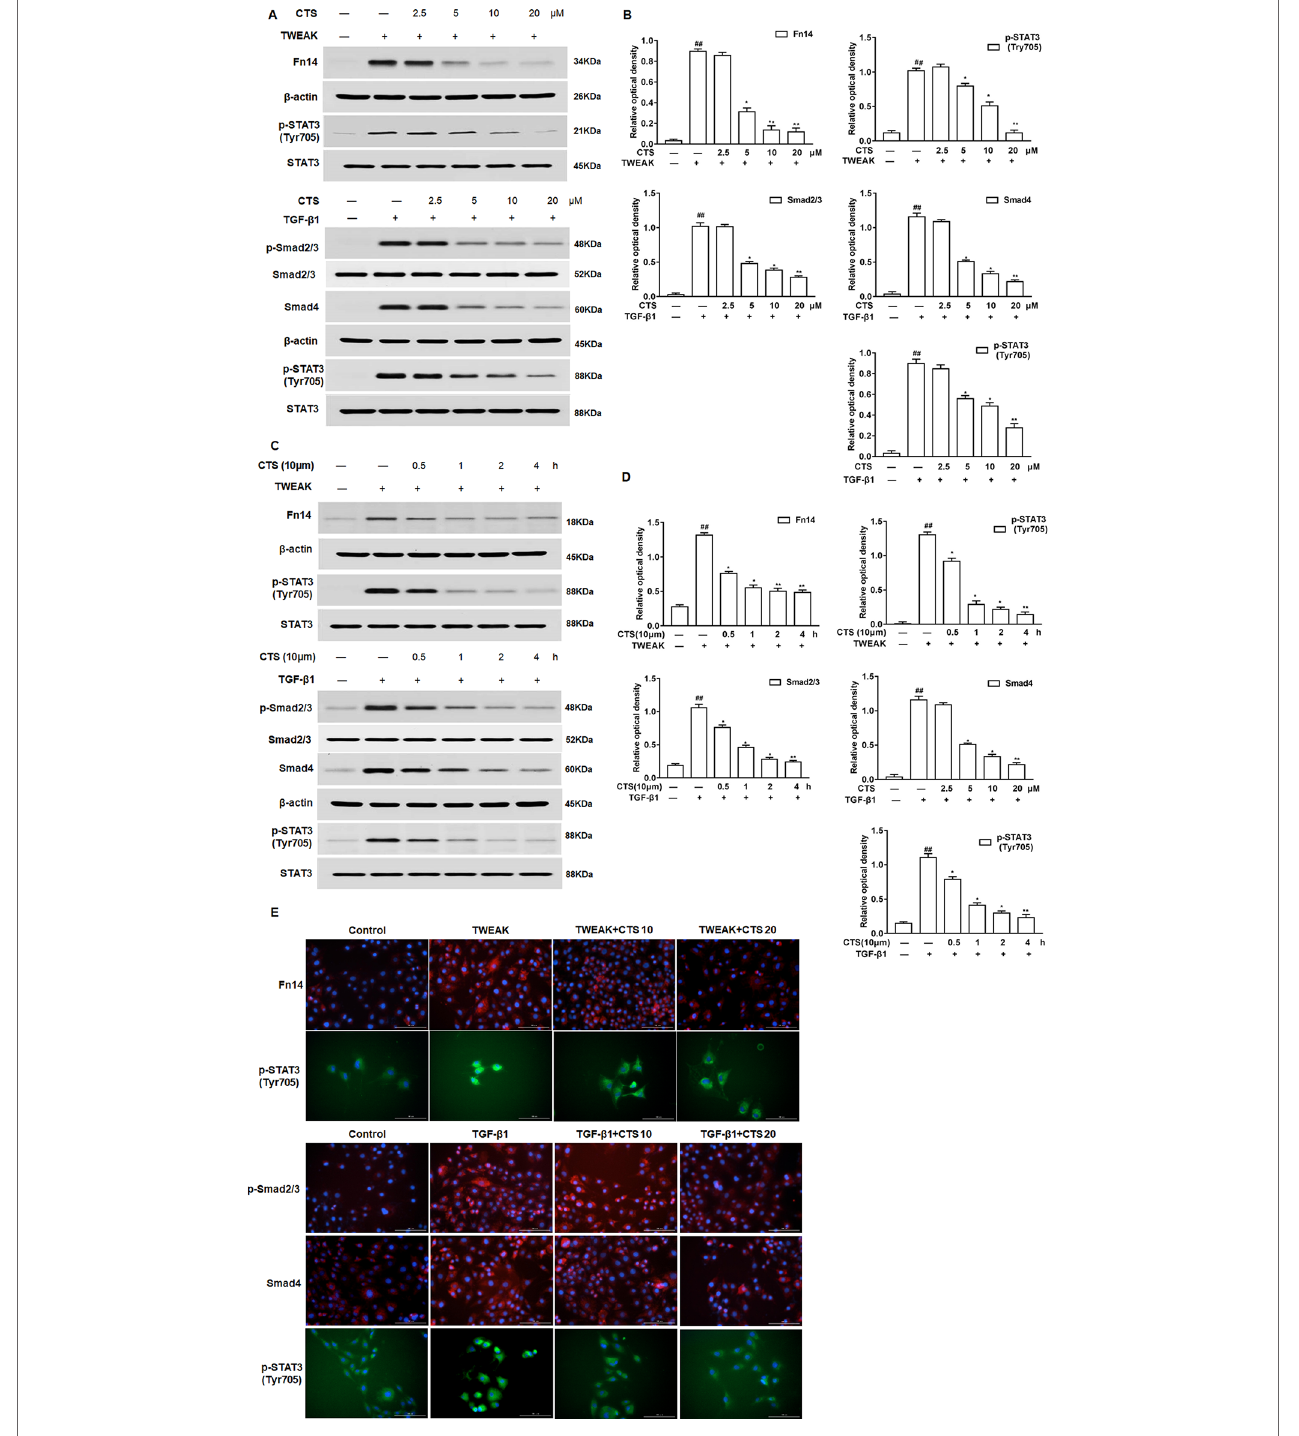
FIGURe 5 | The effect of cryptotanshinone (CTS) on the airway remodeling was through TWEAK/STAT3 and transforming growth factor beta 1 (TGF-β1)/ STAT3. Tumor necrosis factor-like weak inducer of apoptosis (TWEAK) or TGF-β1-induced airway smooth muscle cells (ASMCs) were treated with the indicated concentrations of CTS for 24 h. (A) and (C) The protein expressions of Fn14, p-Smad2/3, Smad4, p-STAT3 (Tyr705), and STAT3 were analyzed by Western blot. (B) and (D) The band intensities of these proteins were quantified in relative to Smad2/3, β-actin, and STAT3. (e) Immunofluorescence staining of TWEAK, TGF-β1, and STAT3 in ASMCs. The magnification was 200×. Fn14 staining (red), p-Smad2/3 staining (red), Smad4 staining (red), p-STAT3 staining (green), and nuclei with 4′,6-diamidino-2-phenylindole (blue) is shown. Data were presented as mean ± SEM (n = 3). ##P < 0.01 vs. untreated group; *P <0.05, **P < 0.01 vs. TWEAK- induced or TGF-β1-induced group.